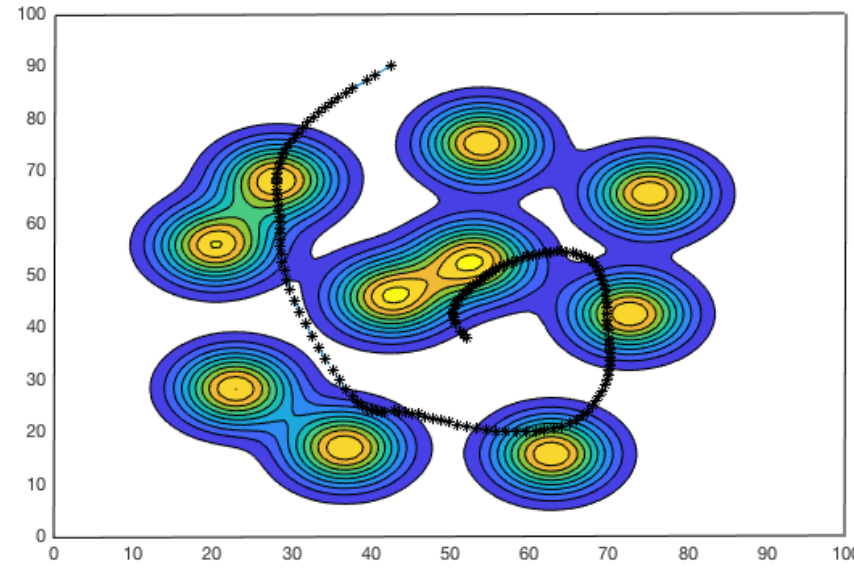
Figure 7. The measurement space of RFID readers and the reference trajectory. Note: The unit of each axes is